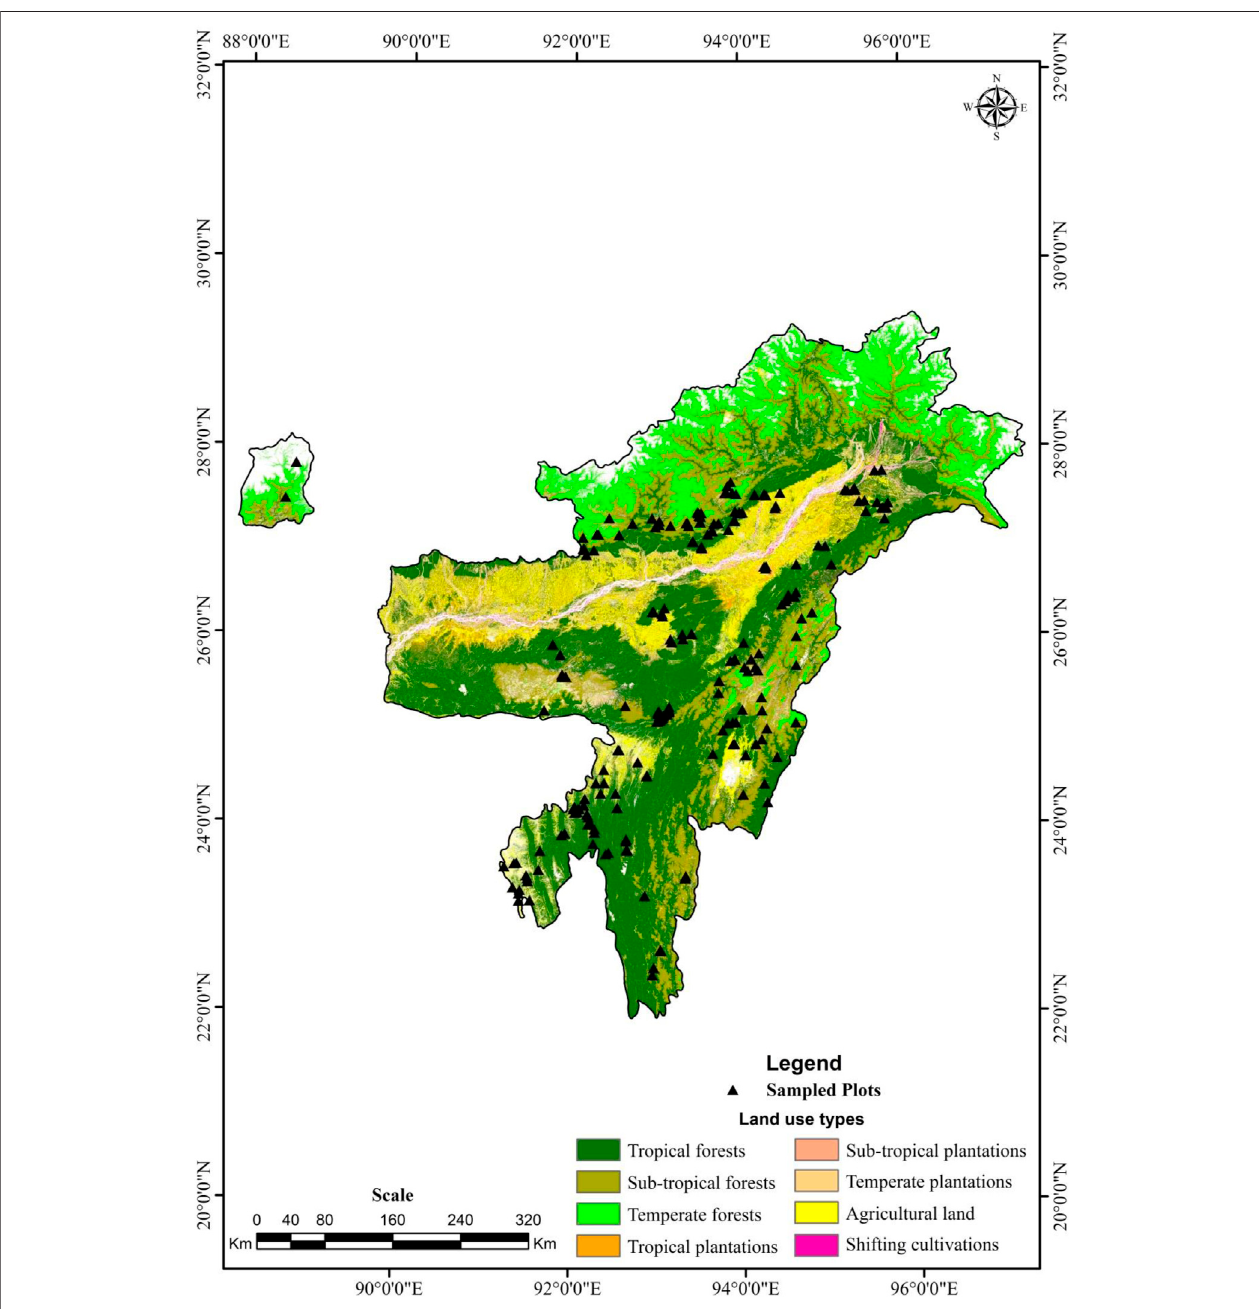
FIGURE 1 | Spatial distribution of major land uses showing sampling plots in northeast India.